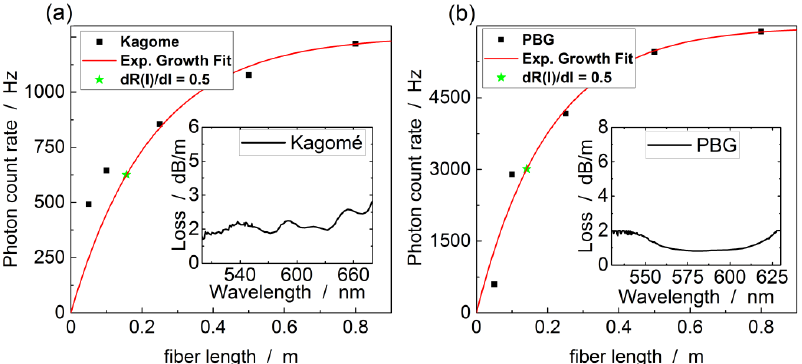
Figure 8. Integrated nitrogen signal plotted over the fiber length at 2 bar pressure for ( a ) kagomé-PCF and ( b ) PBG-PCF. A logarithmic fit is applied to take account of the two-way-attenuation in the fiber. Insets show the loss of the fundamental mode specified by the manufacturer.